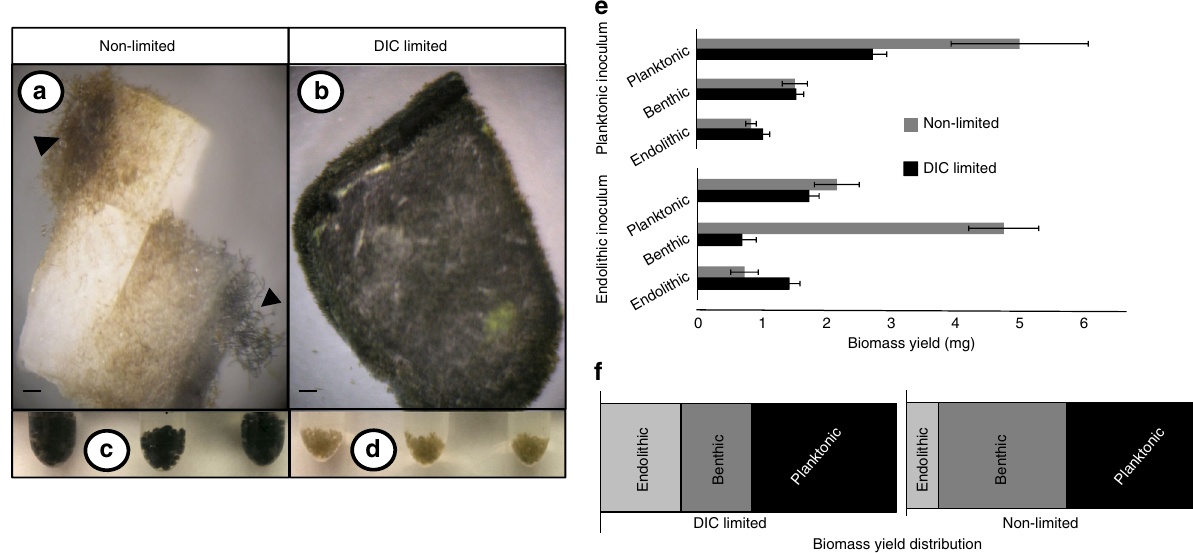
Fig. 1 Effects of dissolved inorganic carbon limitation on M. testarum BC008 cultured biomass. a , b (scale bars = 0.5 mm) both show calcite chips with endolithic and benthic biomass growth. c , d show pelleted planktonic biomass (each tube is an independent replicate). Growth under dissolved inorganic carbon (DIC) limitation produced virtually complete endolithic surface infestation, short benthic outgrowth ( b ), and relatively little, bleached planktonic biomass ( d ). Growth without DIC limitation resulted in asymptomatic, abundant planktonic growth ( c ), but more restricted endolithic yield ( a ). Biomass yield obtained from each growth mode is displayed as a function of initial inoculum type ( e ). f shows relative distribution of the average biomass yield by growth mode under DIC-unlimited and -limited growth conditions. Error bars equal one